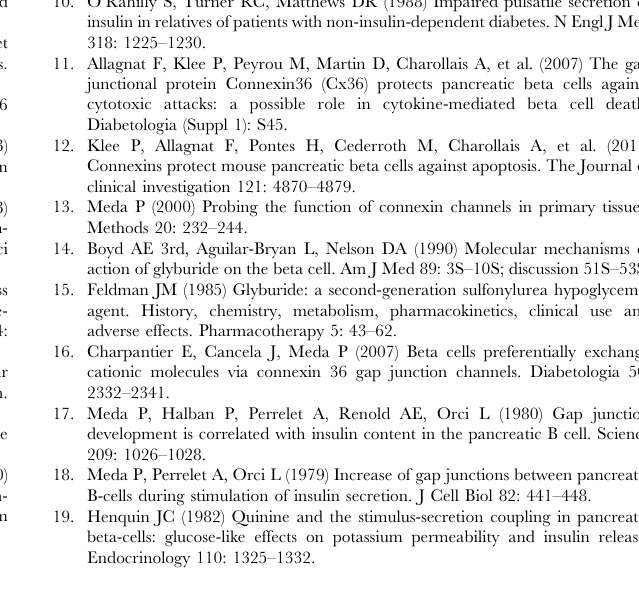
( E ) The same cluster is seen under a rhodamine channel, which detects the regions of highest fluorescence intensity. Deconvolution improves cell detection; ( F ) A region of five pixel width ( yellow line ) is automatically defined around each nuclear region to define the ROIs where fluorescence intensity was recorded as a function of time. Bar, 50 m m in A, B and C, and 10 m m in D, E and F. (TIF) Figure S3 Steps for the automatic evaluation of the ‘‘synchrony index’’. ( A ) Records of fluorescence intensity as a function of time are shown for a fully synchronized ( left column ) and a poorly synchronized cluster ( right column ). Each colour shows the recording from a different cell (for clarity reason, only three cells were selected for these illustrations); ( B ) The envelope of each curve was drawn using a morphological opening and closing operation, resulting in a lower local minimum ( black dotted line ) and an upper local maximum bonds, respectively ( coloured dotted lines ); ( C ) The amplitude of each curve was set to 1, to give each cell recording the same weight; ( D ) An average equalized curve was computed for each cluster; ( E ) The presence of peaks was detected by computing the derivative of each curve; ( F ) The average peak values of all the clusters estimated the ‘‘synchrony index’’, an indicator of the average synchrony of all the MIN6 cells screened in a well. Figure S4 Dose-response relationship of the 24 drugs selected from the primary screening. The effect on synchrony index (relative to that of WT MIN6 cells exposed to DMSO) was plotted as a function of 0.1, 1, 10, 50 and 100 m M concentration of each drug. Data are means 6 SE of at least four independent experiments. { indicate toxic concentrations, as evaluated by cell detachment from the support. Figure S5 Drugs affecting the synchrony index and Cx36 coupling, and selected from the secondary screening, were not toxic to MIN6 cells. The percentage of dead cells, after a 24 h treatment with 10 m M the different drugs selected from the secondary screening, was comparable to that observed in DMSO-exposed controls. No difference was observed between